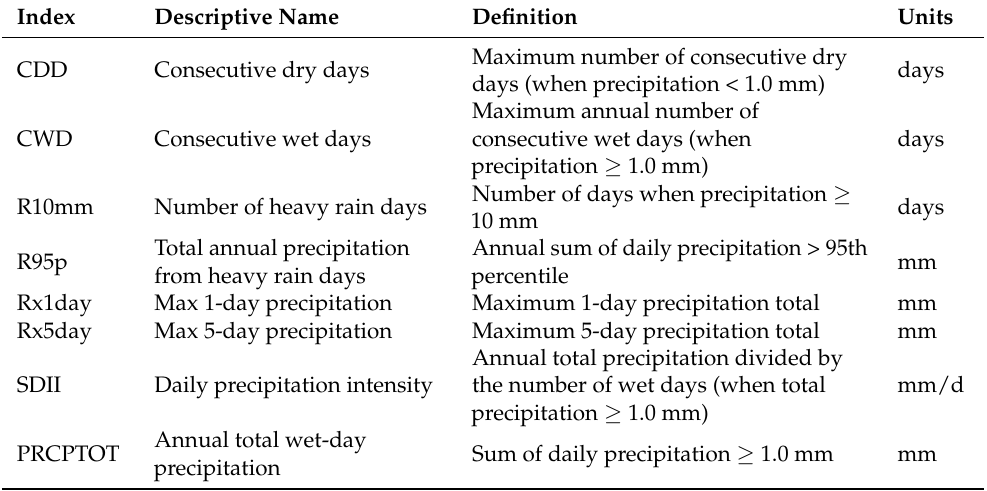
Table 2. Brief description of the eight extreme precipitation indices used in this